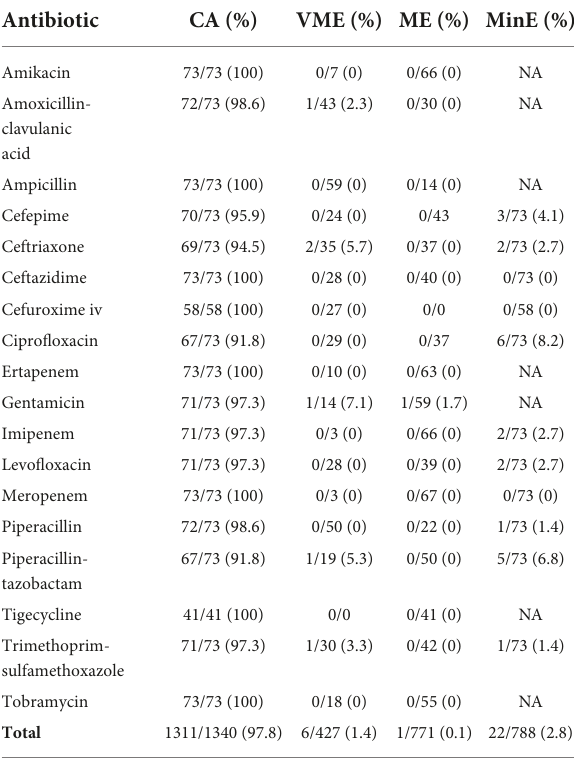
TABLE 3 Results from automated AST (BD Phoenix TM System) of 73 Enterobacterales from a liquid colony following FAST TM System testing on positive blood cultures in both study arms combined.